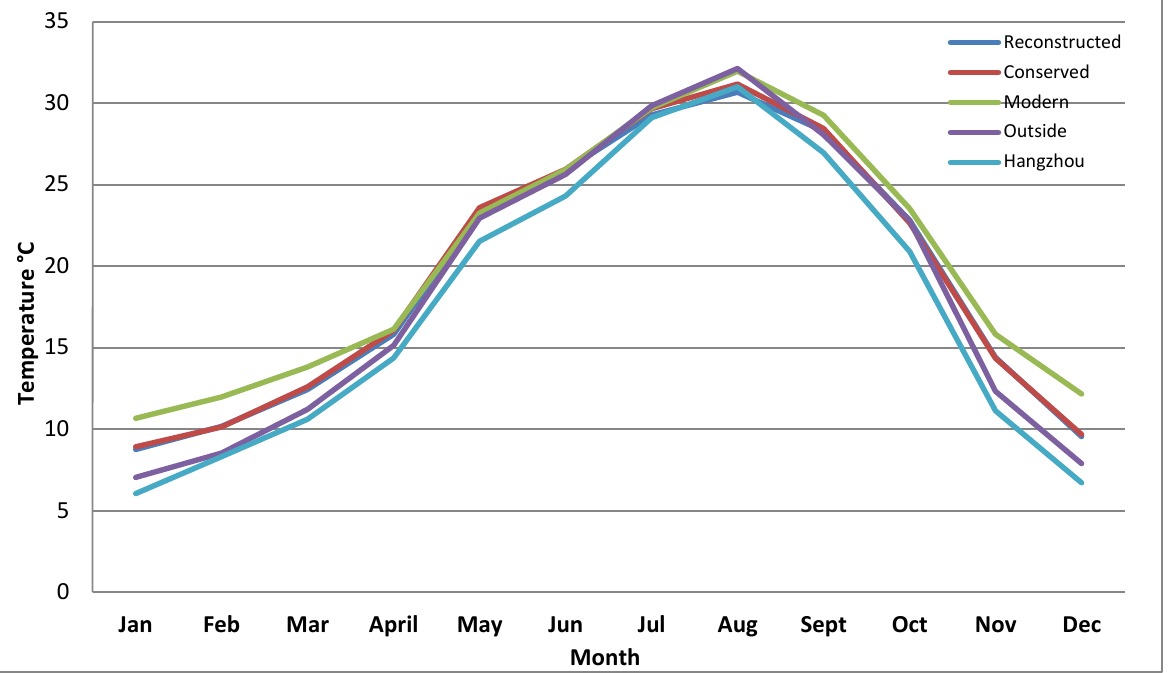
Figure 6 Summary of mean air temperature for a 12-month